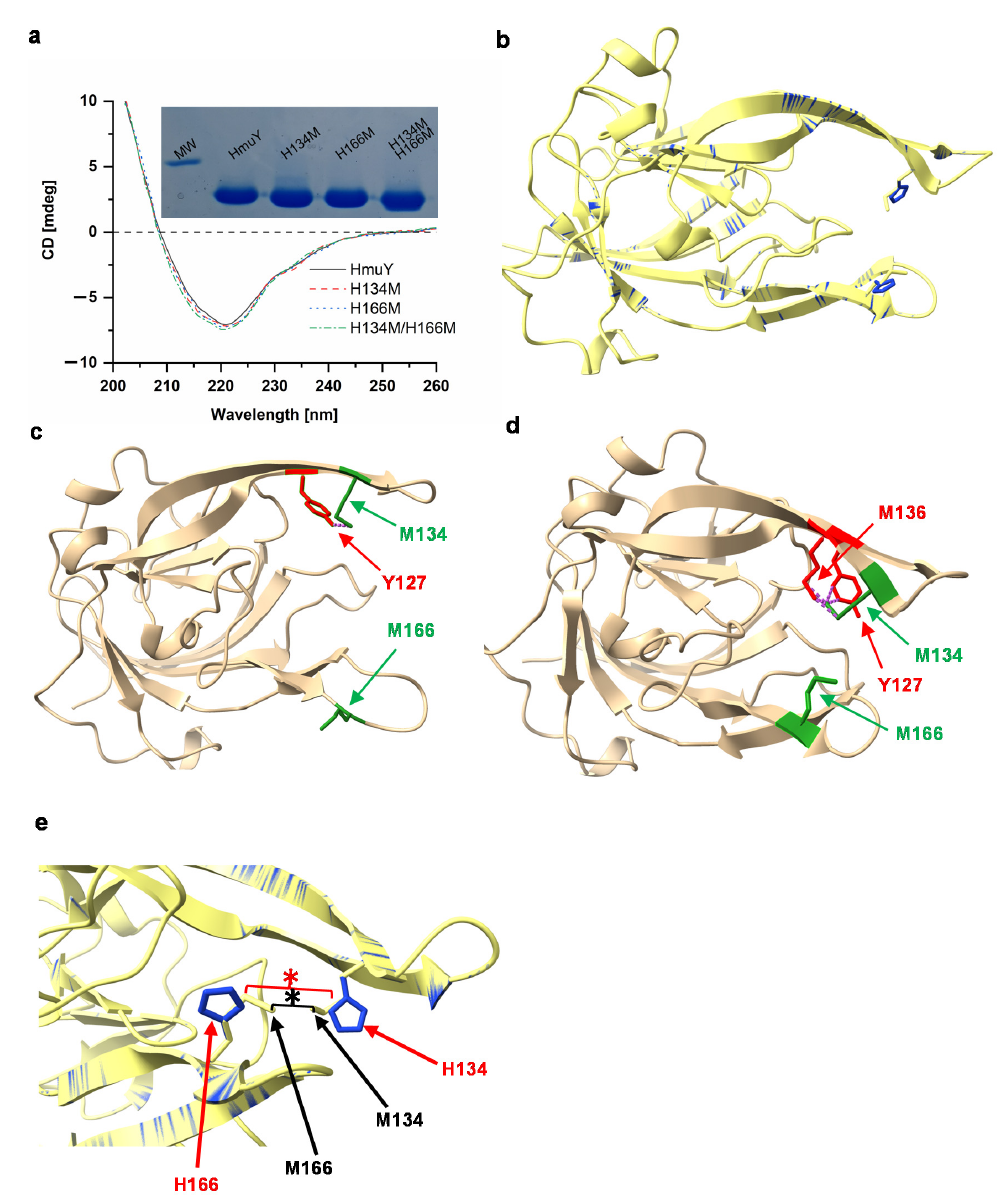
Figure 3. Characterization of HmuY site-directed mutagenesis variants. Proteins were overexpressed, purified, and analyzed by SDS-PAGE and CBB G-250 staining ( a , inset). ( a ) Secondary protein structures of purified apoproteins determined by far-UV CD spectroscopy and ( b ) tertiary protein structures of the overlapped native HmuY in complex with heme (blue) (PDB ID: 3H8T) and the H134M/H166M protein variant (yellow) analyzed by theoretical modelling [35,36]. ( c ) Modeled three-dimensional apoprotein structure (PDB ID: 6WEM), ( d ) protein structure of HmuY-heme complex (PDB ID: 3H8T), and ( e ) its heme-binding pocket. ( c ) Potential steric hindrance between methionine at position 134 (M134, green) and tyrosine at position 127 (Y127, red) in the apo-HmuY structure (PDB ID: 6WEM). Potential steric hindrance between M134 and M136 in the HmuY-heme complex structure (PDB ID: 3H8T). ( e) Substitution of two histidines (shown by red arrows) by two methionines (shown by black arrows) may result in reducing the space of the heme-binding pocket. Reduced distance indicated by red and black asterisks.